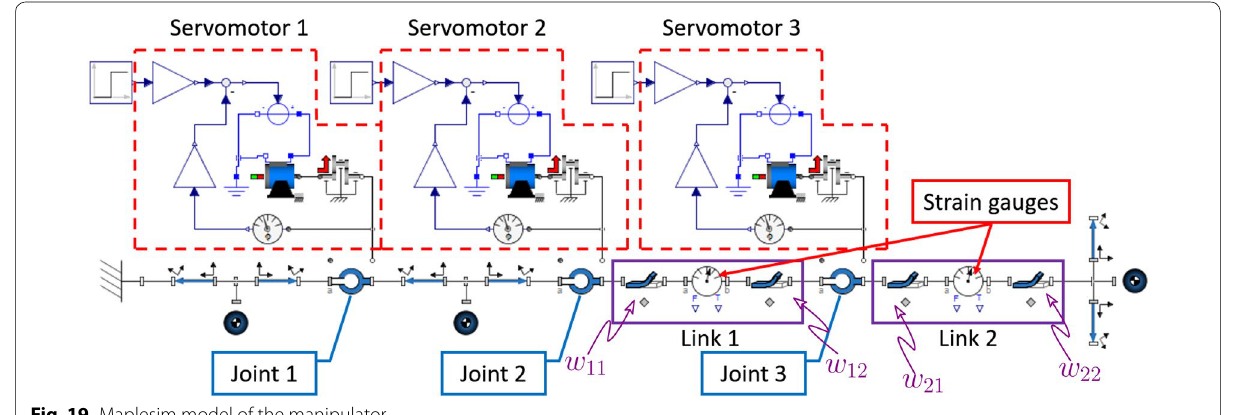
Fig. 19 Maplesim model of the manipulator